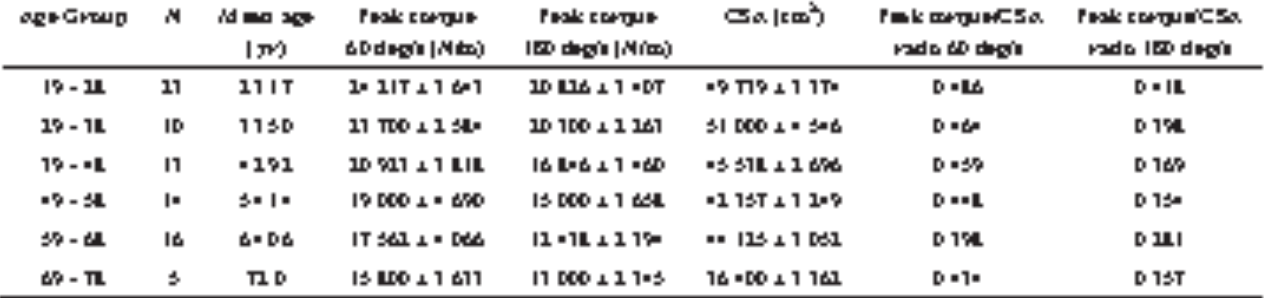
Table I : Mean values ±S.D. for peak torque in external rotation at 60 deg/s and 180 deg/s and